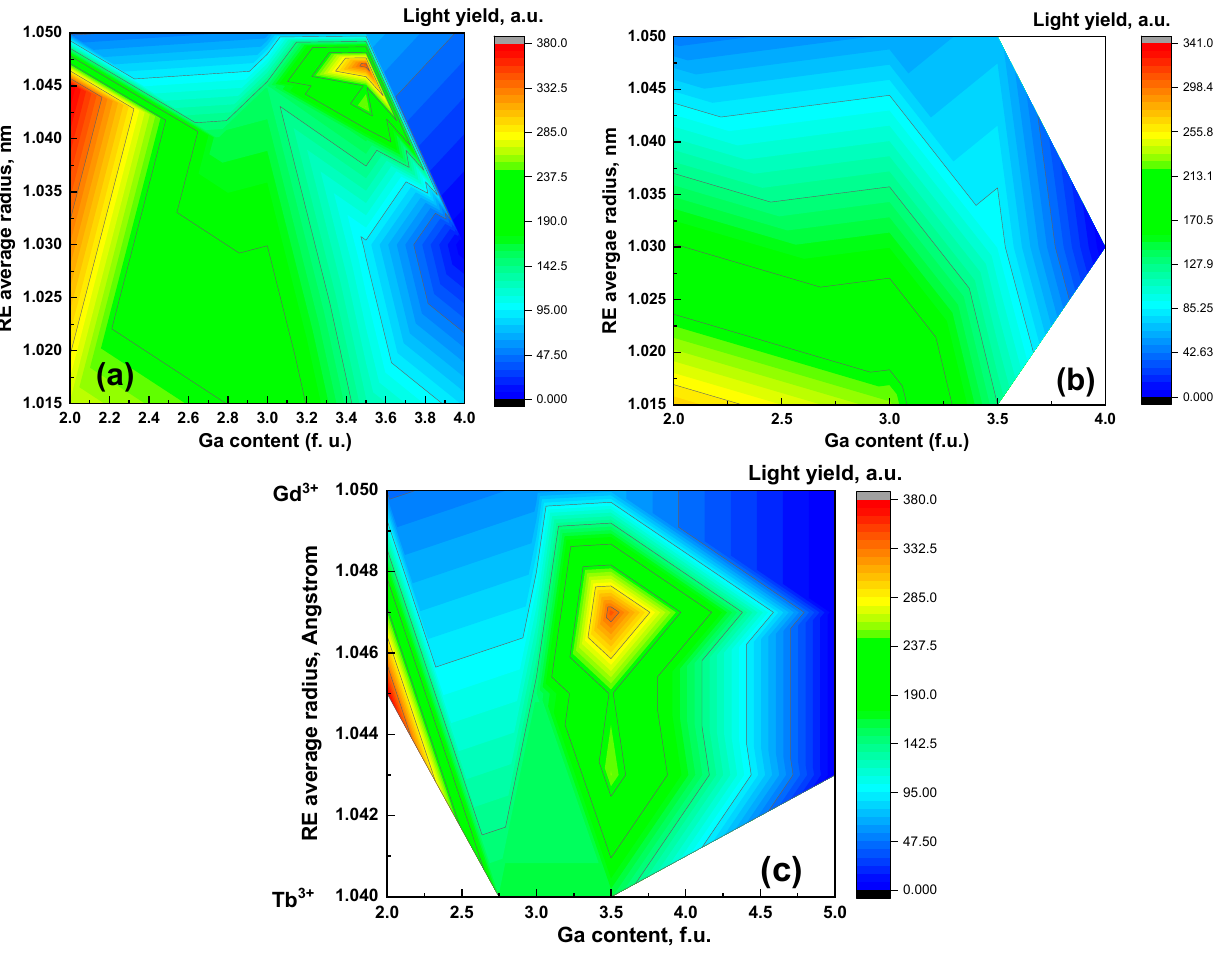
Figure 4. Light yield in (Gd,Lu,Tb) 3 (Al,Ga) 5 O 12 :Ce films on GAGG:Ce substrates in dependence on average ionic radius of the rare earth ion and Ga content in the films under α -particle excitation in ( a ) all the sample series, ( b ) Lu-Gd-substituted films, and ( c ) Gd-Tb-substituted films. The scintillation decay times predictably decreased with Ga content (Figure 5),